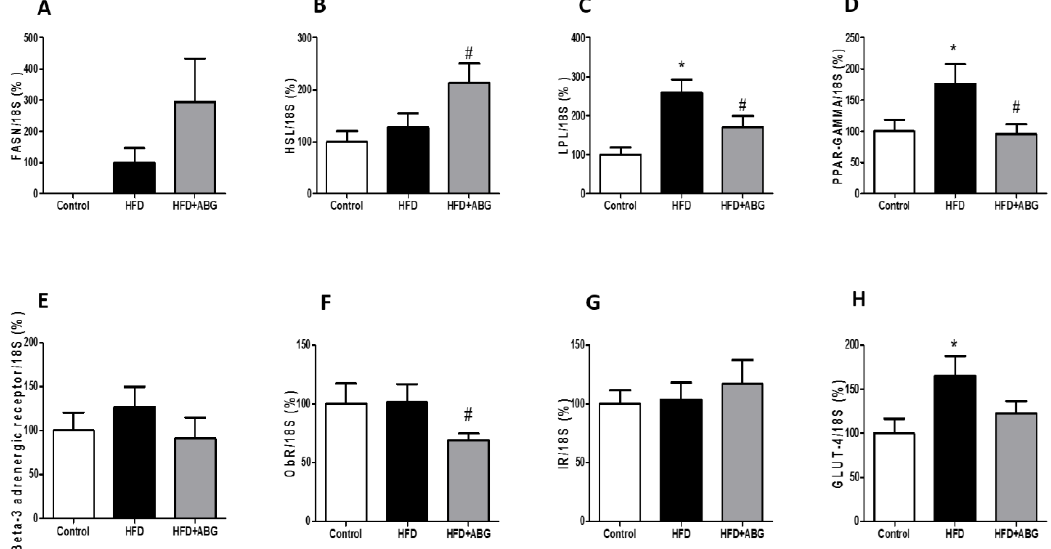
Figure 5. mRNA concentrations of fatty acid synthetase ( A ), hormone-sensitive lipase ( B ), lipoprotein lipase ( C ), peroxisome proliferator-activated receptor gamma ( D ), beta-3 adrenergic receptor ( E ), leptin receptor ( F ), insulin receptor ( G ) and glucose transporter 4 ( H ) in subcutaneous adipose tissue of rats fed a standard chow (control) or a high fat diet/sucrose diet (HFD) and treated with vehicles or HFD + ABG. Data are represented as mean ± SEM; n = 8 samples/group. * p < 0.05 vs. control; # p < 0.05 vs. HFD.